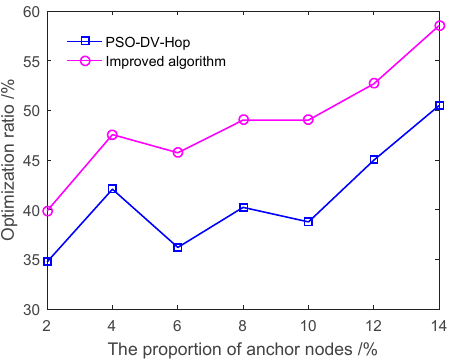
Figure 8. Comparison of the optimization ratio of the PSO algorithm and the algorithm of this paper.